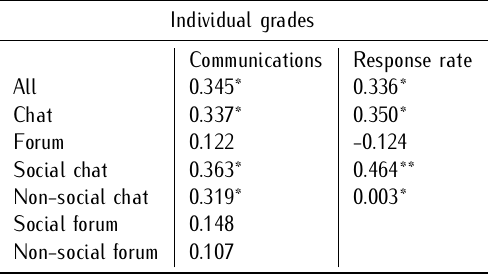
Table 3. LIWC categories with significant differences. *p < 0.1, **p < 0.05